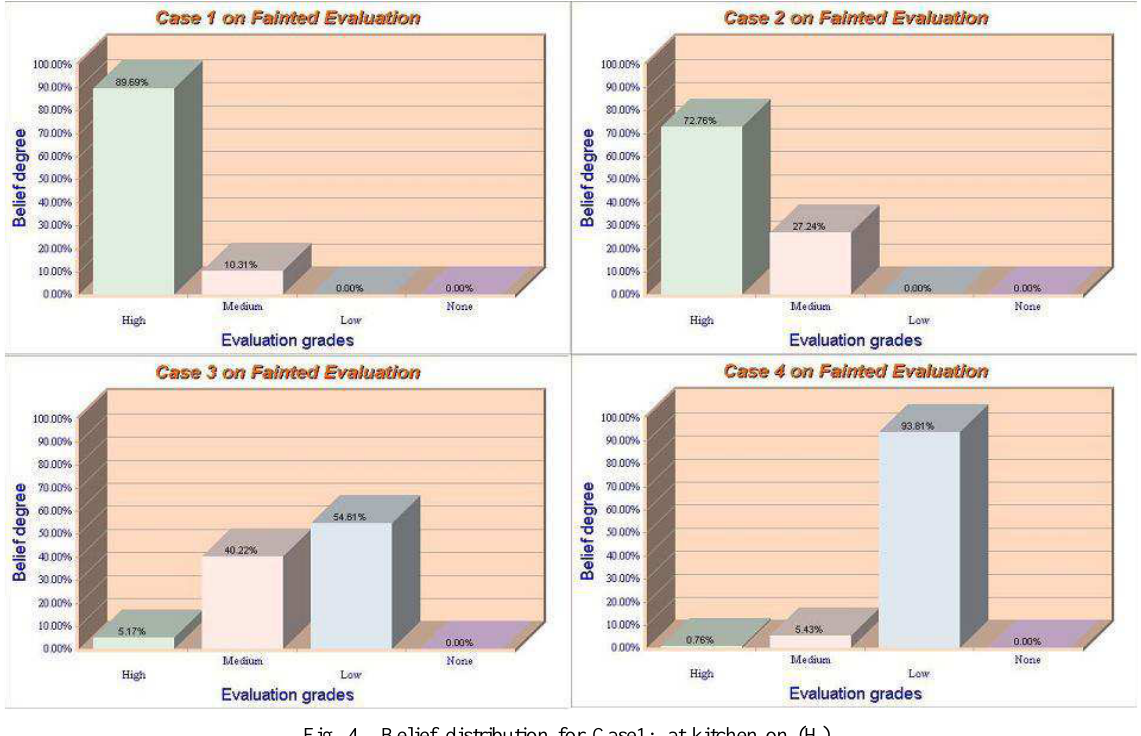
Fig. 4. Belief distribution for Case1: at kitchen on